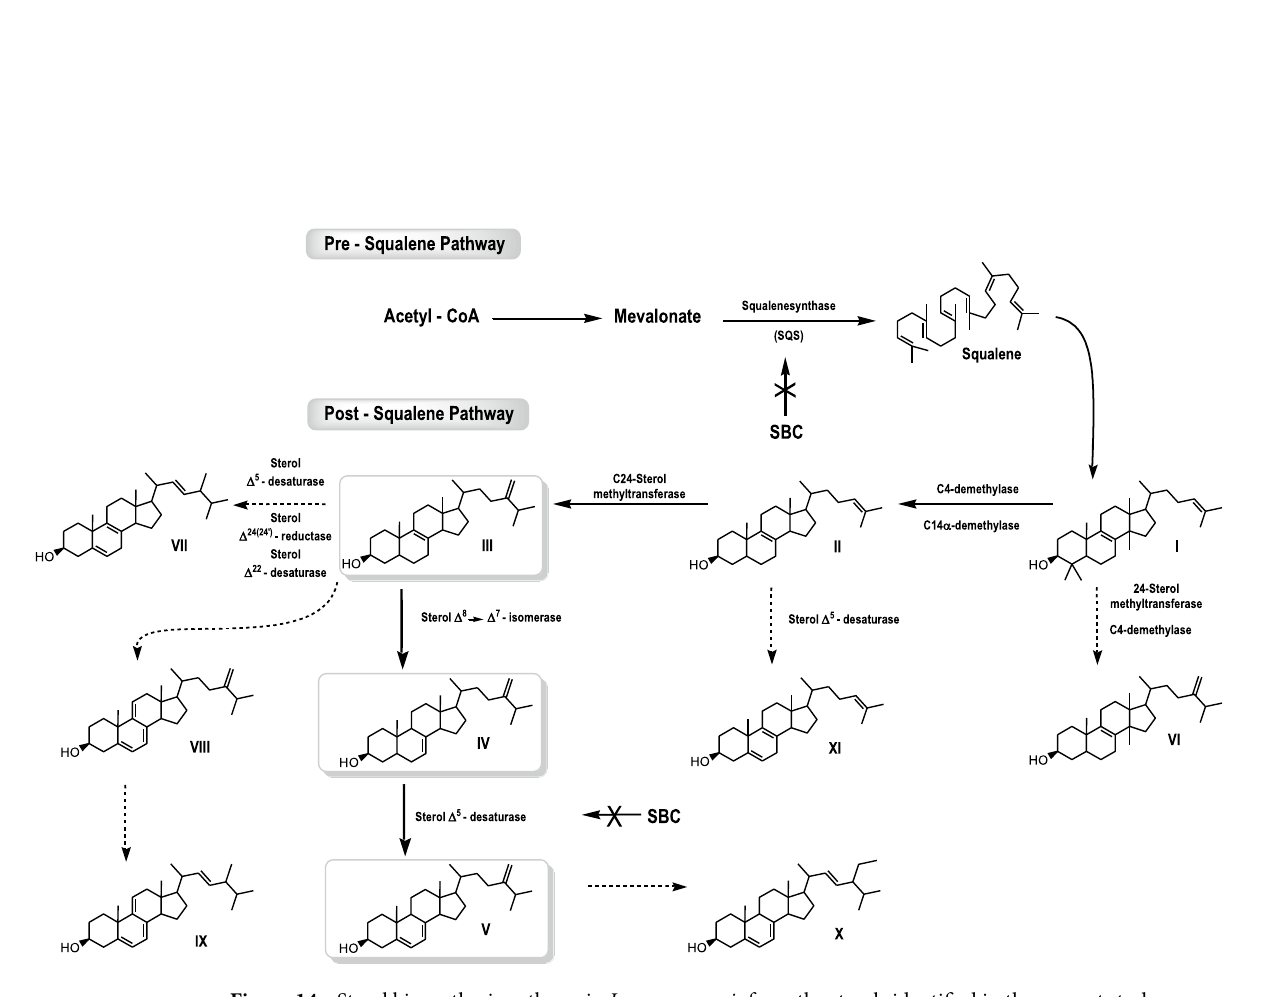
Figure 14. Sterol biosynthesis pathway in L. amazonensis from the sterols identified in the current study. (I) 4,4 ′ ,14-trimethyl-cholesta-8,24-dien-3β-ol (lanosterol); (II) cholesta-8,24-dien-3β-ol (zymosterol); (III) ergosta-8,24(24 ′ )-dien-3β-ol (fecosterol); (IV) ergosta-7,24(24 ′ )-dien-3β-ol (episterol); (V) ergosta-5,7,24(24 ′ )- dien-3β-ol (5-dehydroepisterol); (VI) 14-methyl-ergosta-8,24(24 ′ )-dien-3β-ol; (VII) ergosta-5,8,22-trien-3β-ol; (VIII) ergosta-5,7,9(10)-24(24 ′ )-tetraen-3β-ol; (IX) ergosta-5,7,9(10)-22-tetraen-3β-ol; (X) stigmasta-5,7,22- trien-3β-ol; (XI) cholesta-5,8,24-trien-3β-ol. Thick lines indicate main reaction pathways. Dashed arrows show intermediate sterols of lower quantity. Arrows marked with an ‘X’ indicate inhibitory interactions of the SBC